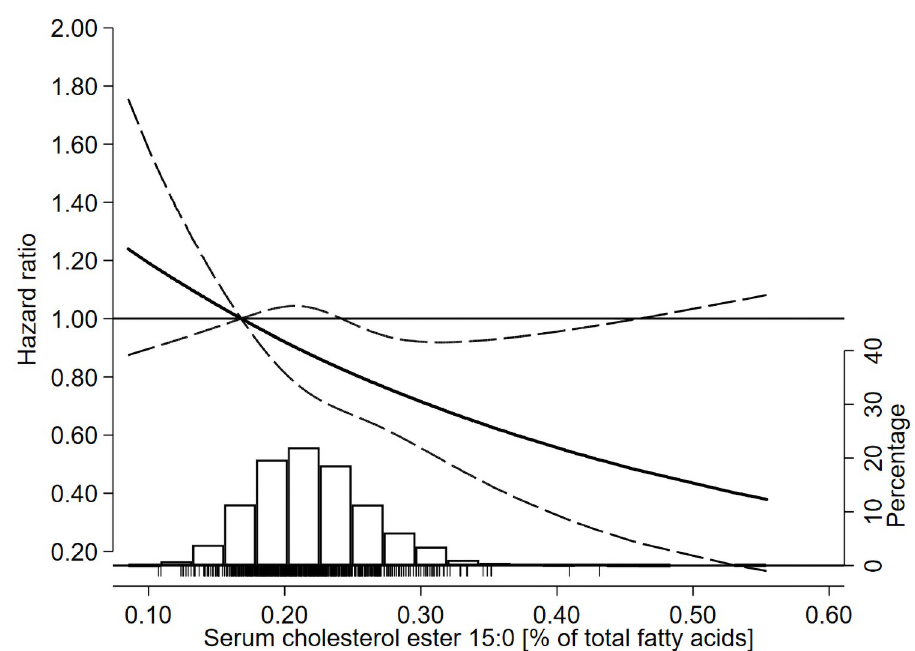
Fig 1. HRs of incident CVD as a function of serum pentadecanoic acid (15:0) in the 60YO study. Data were fitted using Cox regression models adjusted for baseline age, sex, BMI, alcohol intake, smoking habits, physical activity, education, and prevalent hypertension, hyperlipidaemia, and type 2 diabetes. Dashed lines represent 95% confidence limits. The reference value of serum 15:0 is the 10th percentile (i.e., 0.17% of total fatty acids). The histogram shows the distribution of serum 15:0 in the cohort, and the tick marks under the histogram indicate serum 15:0 levels of individuals who experienced an incident CVD event during follow-up. CVD, cardiovascular disease; HR, hazard ratio.